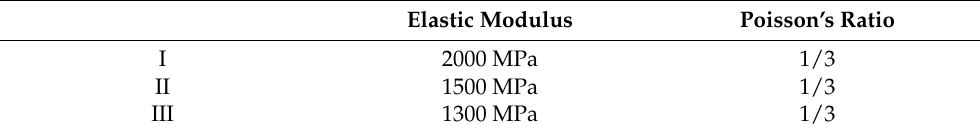
Table 2. Material parameters.